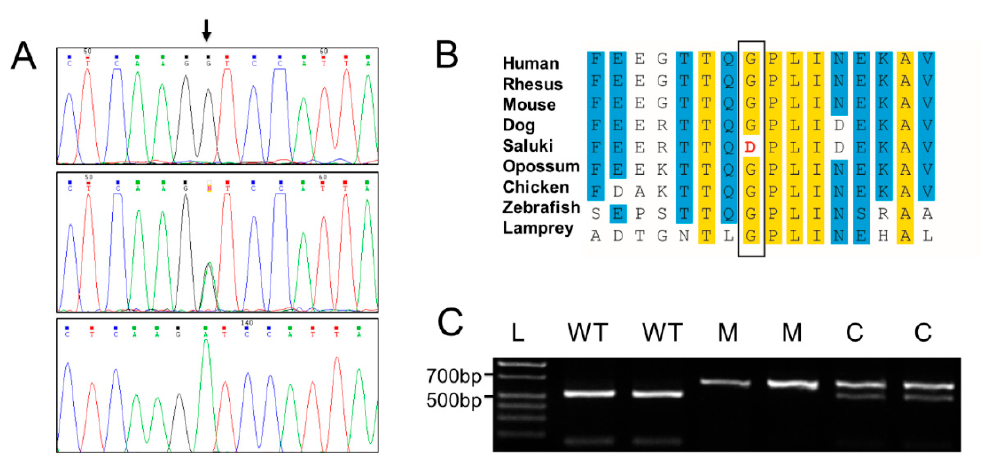
Figure 6. SSADHD-associated ALDH5A1 missense variant in Saluki dogs. ( A ) The electropherograms from a normal dog (top panel), a heterozygous dog (middle panel) and a dog homozygous for the variant in ALDH5A1 indicated by an arrow. ( B ) The amino acid alignment around the missense variant in ALDH5A1 (XP_013966074.2: p.(Gly288Asp)). Yellow boxes indicate 100% conservation across the species listed to the left and blue boxes indicate 75% conservation. The variant amino acid residue is boxed and the variant allele detected in affected Salukis is shown in red. ( C ) The PCR-RFLP genotyping assay for the ALDH5A1 missense variant is shown. After PCR amplification, the products were digested with Sau96I. L is the DNA ladder, WT stands for wild type (542 bp), C for carrier and M for mutant (702 bp).